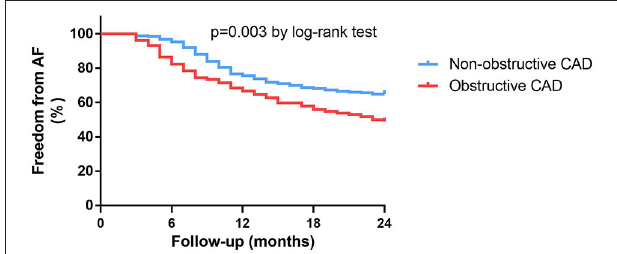
FIGURE 2 | Kaplan-Meier survival curves for freedom from atrial fibrillation recurrence in patients with or without obstructive CAD at 24-month